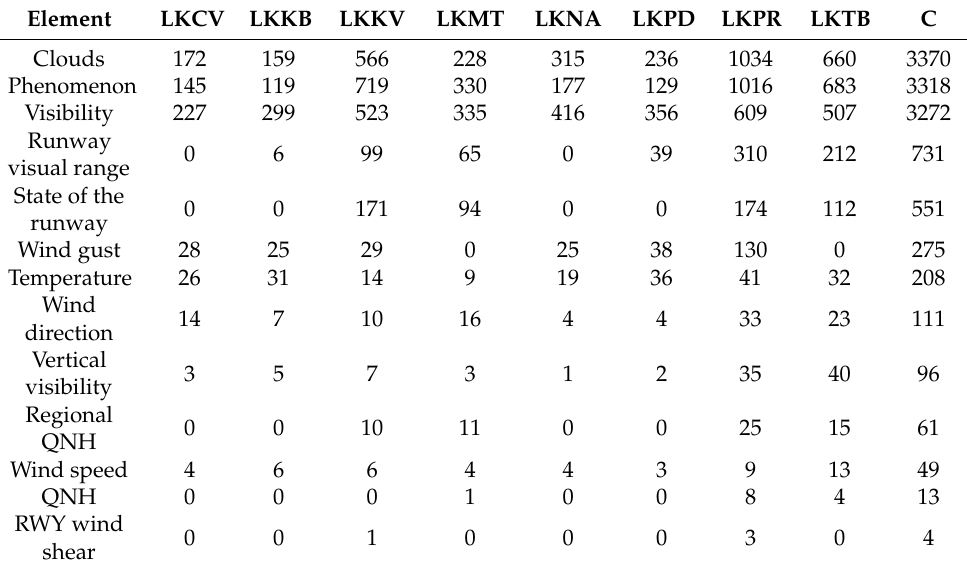
Table 8. Overview of the number of criteria met for the SPECI issue per